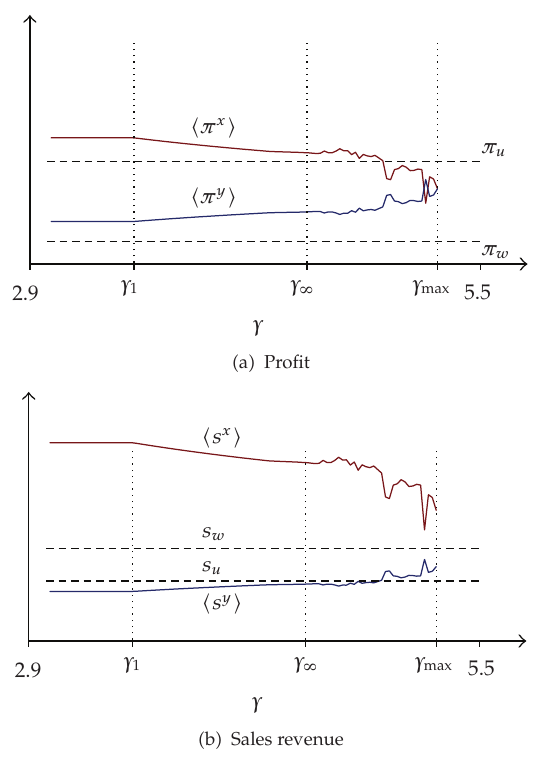
Figure 5: Long-run averages with respect to γ (cid:2) m (cid:6) 3 ,c (cid:6) 1 (cid:3)